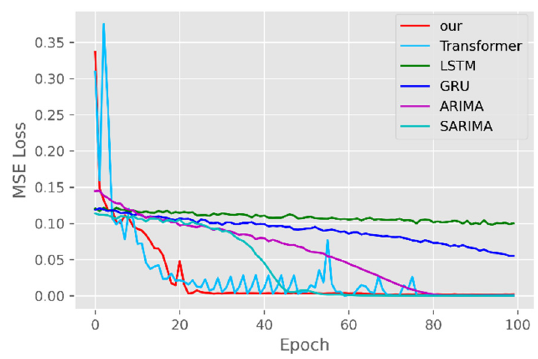
Figure 7. Comparison of training loss for CA vaccines.